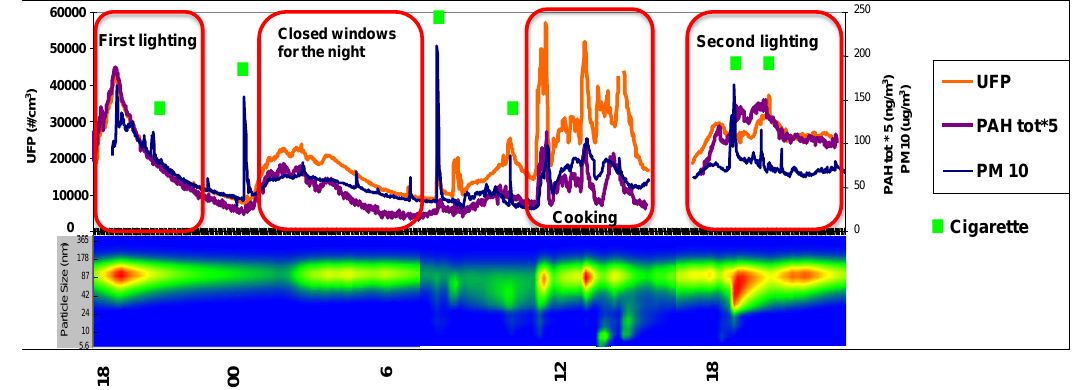
Figure 3. Temporal trend of PM 10 , UFP and total PAH concentrations in House 1. The FMPS spectrum is reported in the bottom